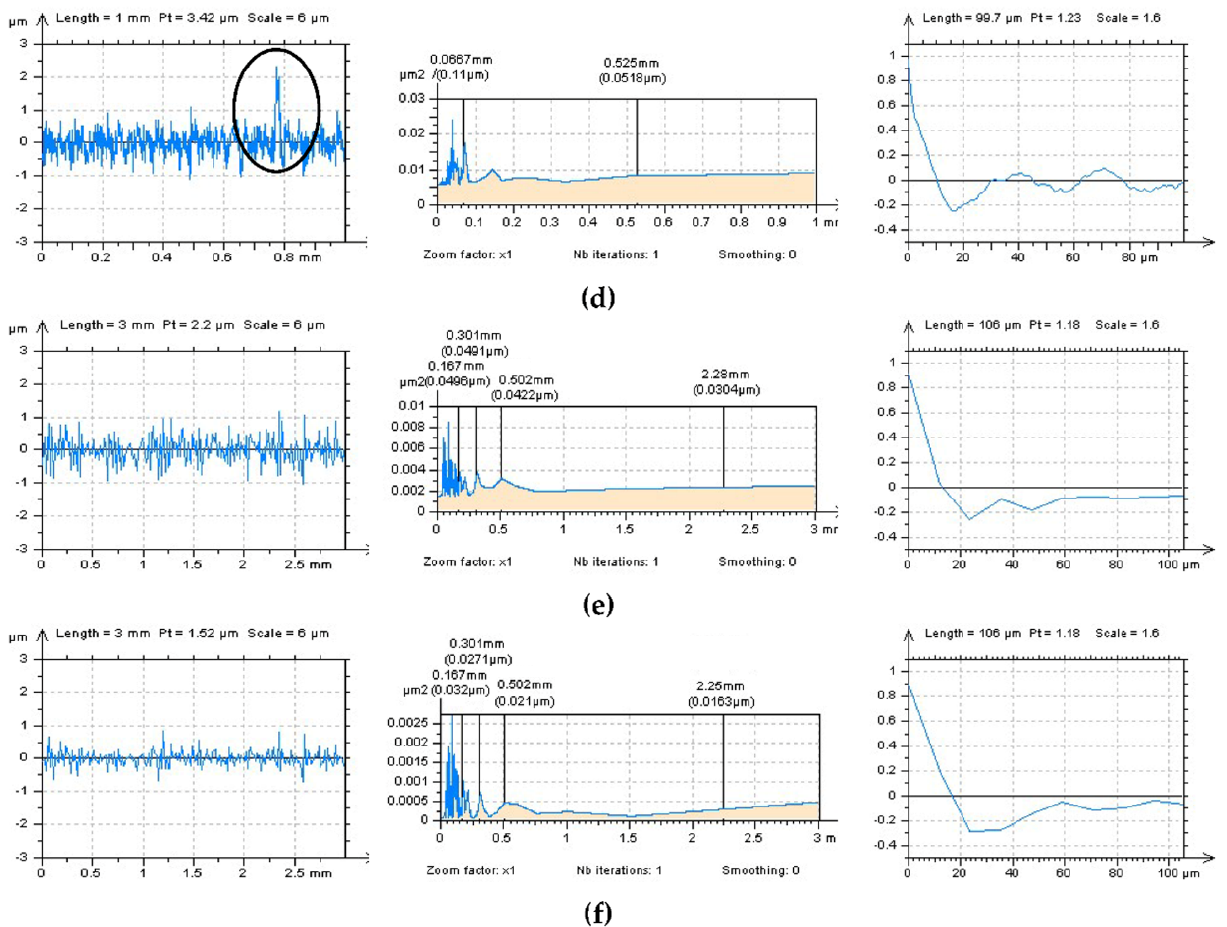
Figure 13. NPs (left column), their PSDs (middle) and ACFs (right), described for profiles from zero wear ( a , b ), running-in ( c , d ) and worn ( e , f ) cylinder liner surface topography measured with 0.5 mm/s velocity and received by GF ( a ), FFTF ( b ), DMF ( c ), SF ( d , e ) and RGF ( f ) approach, with cut-off equal to 0.015 mm ( a , b ), 0.035 mm ( c , d ) and 0.025 mm ( e , f